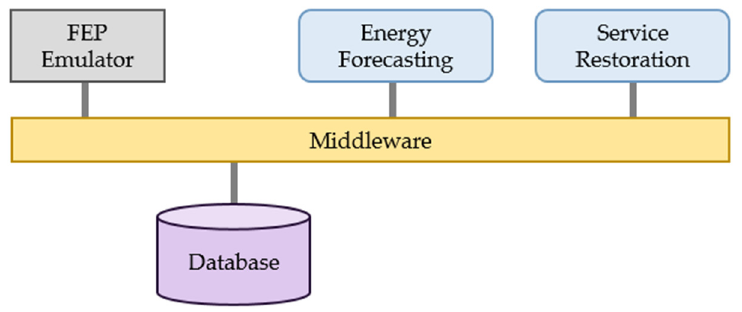
Figure 11. A prototype of the MG-EMS platform.